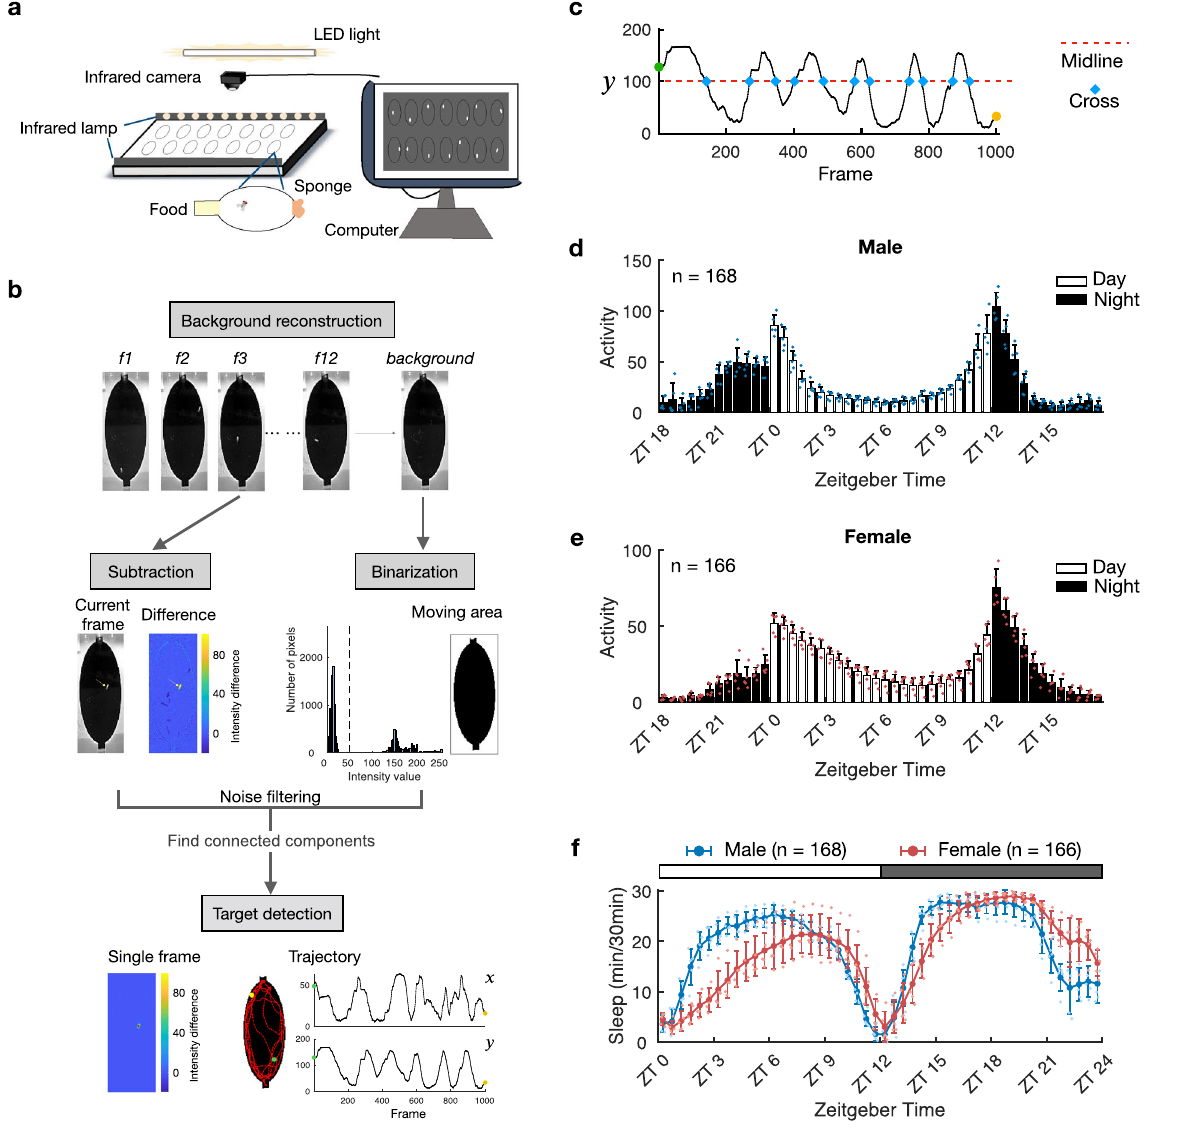
Fig. 1 High resolution video platform for tracing fl ies ’ locomotion activities. a Schematic of the experimental device. The cold light source was used to provide periodic light to the fruit fl y to maintain the normal circadian clock; the infrared camera was placed directly above the observation area; two rows of infrared lights were arranged on both sides of this area; the food was placed at one end of the chamber and a sponge at the other. b The videos obtained by the infrared camera were analyzed by computer program (see “ Methods ” ). c Imitating the DAMS with the trajectory of the fl y. The midpoint of the y- coordinate is used to calculate how many times the fl y has interrupted the infrared beam if it is in the DAMS. d – e Average daily activity pro fi les of male and female fl ies in 3 days (72 h) within each 30 min bin. The white and black columns indicate activities during the light and dark phases, respectively. f Average sleep pro fi les of male and female fl ies in 3 days within each 30min bin. The white and black bars above indicate the light and dark phases, respectively. The blue curve is for male fl ies, red curve is for female fl ies. The error bars in ( d – f ) indicate SEM for fi ve biologically independent experiments and n for the number of fl ies